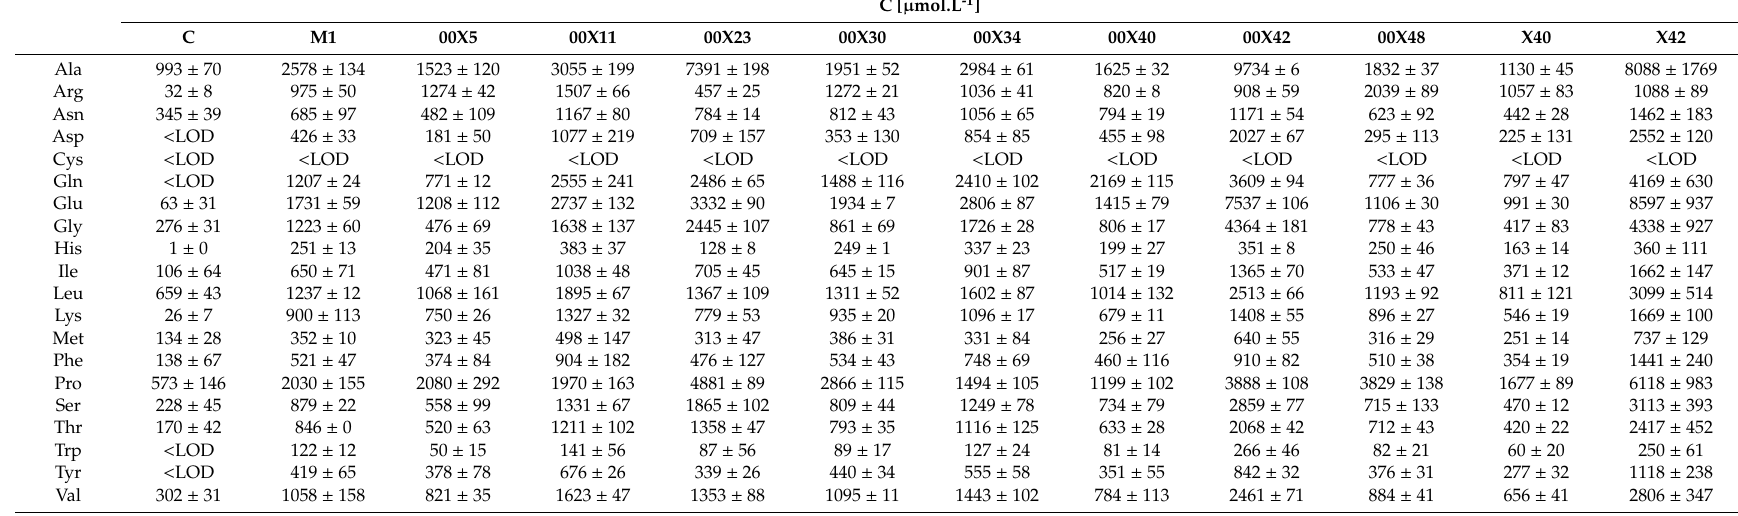
Table 2. The free amino acid content in the medium. < LOD, under the limit of detection. Each code (00X5, 00X11, 00X23, 00X30, 00X34, 00X40, 00X42, 00X48, X40, X42, and M1) represents a Pythium strain. Control (C) is a sterile, non-inoculated cultivation medium. C [ µ mol.L -1